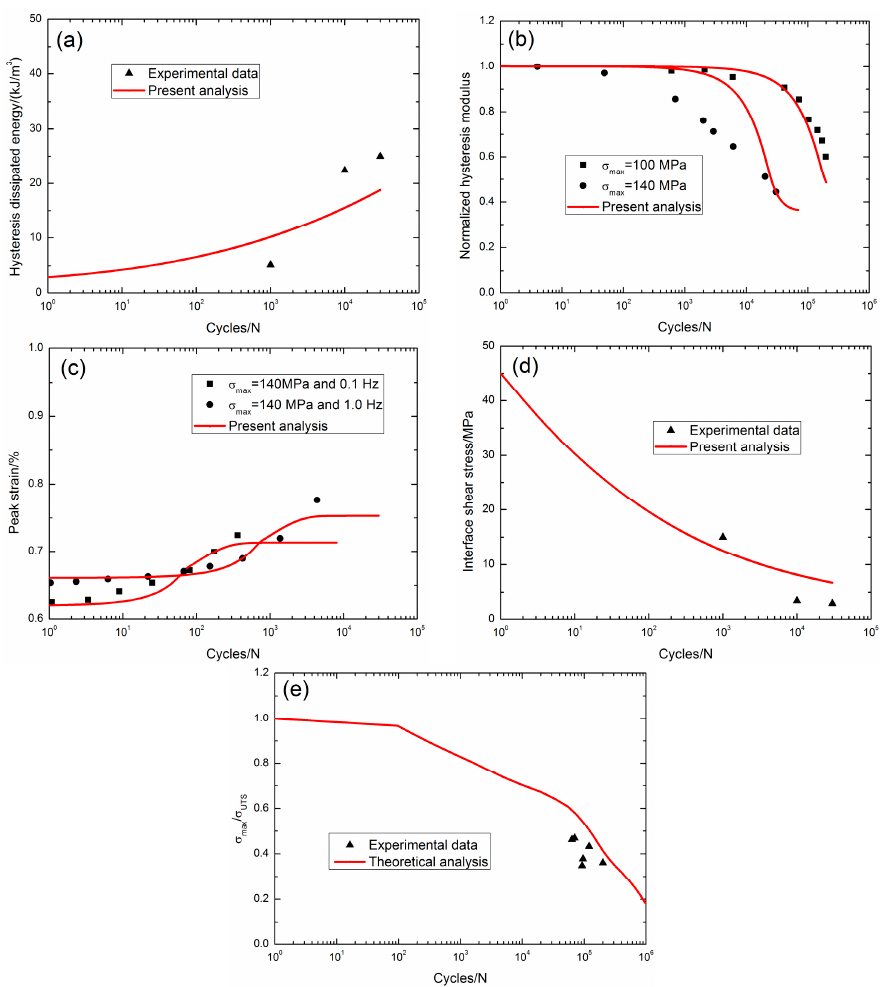
Figure 6. ( a ) The fatigue hysteresis dissipated energy versus applied cycles; ( b ) the normalized fatigue hysteresis modulus versus applied cycles; ( c ) the peak strain versus applied cycles; ( d ) the interface shear stress versus applied cycles; and ( e ) the fatigue life S-N curves of 2D SiC/SiC composite at 1200 °C in air [5].